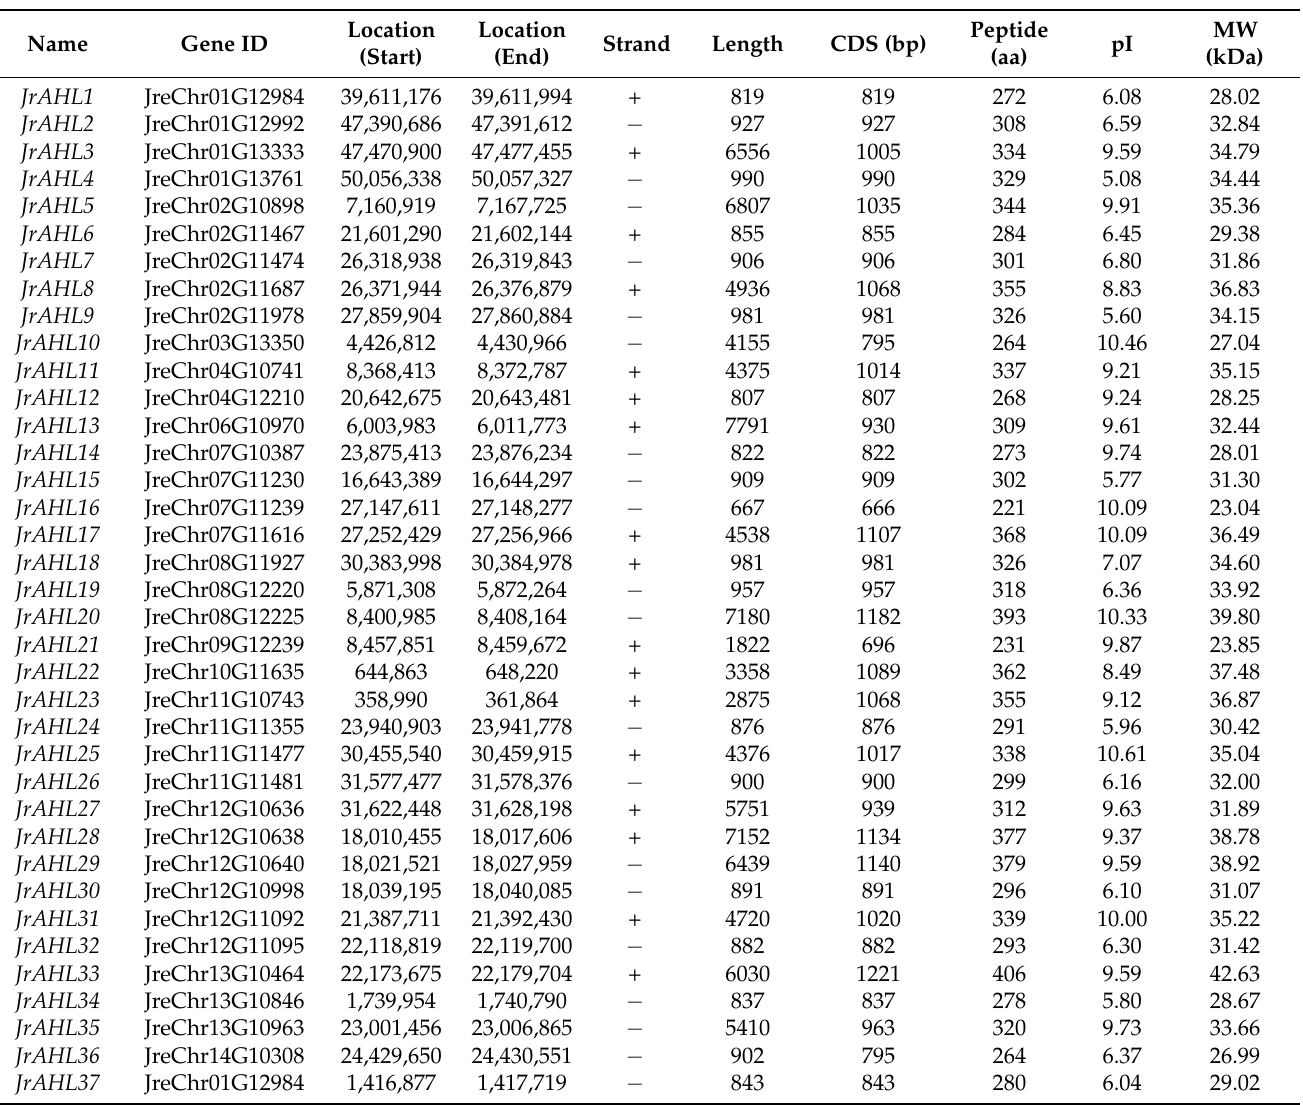
Table 1. Information of the AHL genes in J. regia